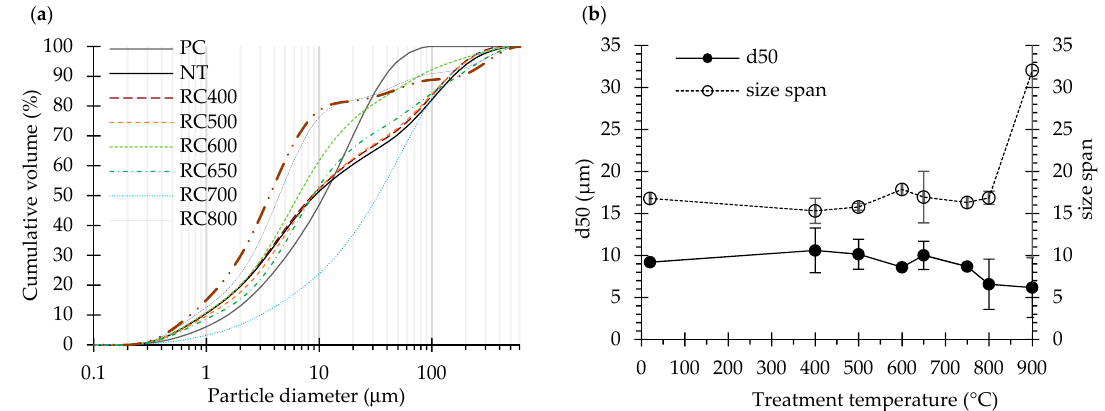
Figure 3. Particle size distribution of PC, NT and RC: ( a ) Cumulative volume distribution; ( b ) median particle size (d 50 ), particle size span (cid:4672) (cid:3031) (cid:3125)(cid:3116) (cid:2879)(cid:3031) (cid:3117)(cid:3116)